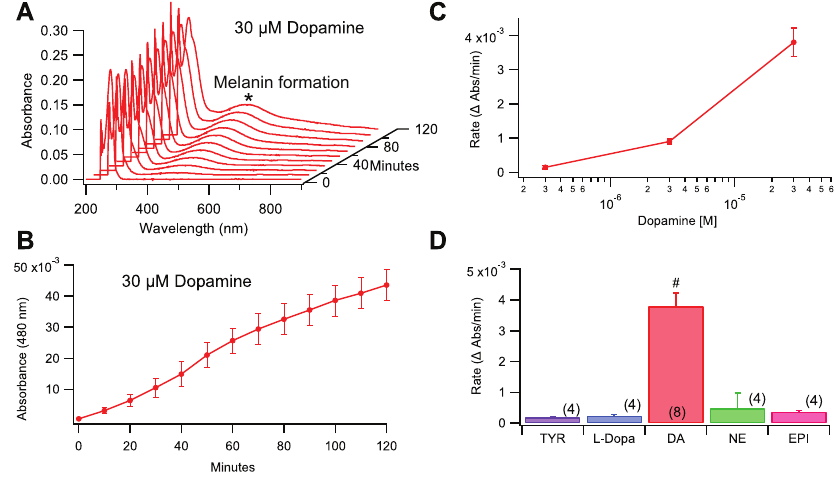
Figure 1. Spectrophotometric characterization of DA melanogenesis, sensitivity to initial substrate concentration, and comparison with DA precursors and metabolites. ( A ) Waterfall plot of full spectrum (190–900 nm) absorbance demonstrating the progressive melanogenesis of DA at 30 µ M. The 480 nm peak indicated with an * represents DA melanogenesis. ( B ) This graph summarizes the kinetics of the 480 nm peak ( n = 8) over two hours representing an increase in the DA melanogenesis. ( C ) The rate of growth ( ∆ Abs / min) of DA melanogenesis (given by the growth of an absorbance peak at 480 nm over a two-hour collection interval as determined by linear regression) was dependent on initial DA concentration. ( D ) This graph compares the rate of growth of DA melanogenesis to that produced by its amino acid precursors and metabolic derivatives (all at 30 µ M concentration): tyrosine (Tyr); l -dopa; norepinepherine (NE); and epinephrine (EPI). While all species tested show melanogenesis, DA polymerizes to melanin at a significantly faster rate. Values in parentheses represent n values. Hashtag # indicates significance level p < 0.0001. Data is presented as mean ±